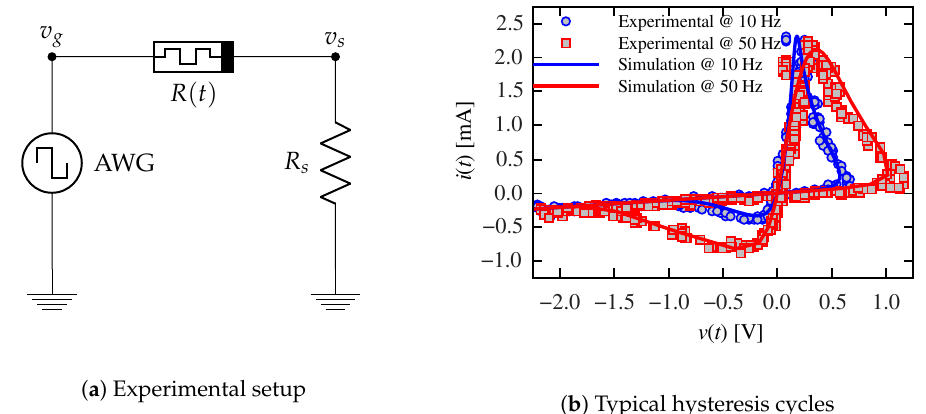
Figure 4. Emulator results: ( a ) experimental setup. The circuit under test is driven by an arbitrary waveform generator (AWG). Current through the memristor is measured as a voltage drop on an in-series resistor R s = 1 k Ω . ( b ) circuit current vs. memristor voltage: simulation (solid line) and measured emulator (points) results. The AWG provides a variable frequency sinusoidal signal with amplitude A = 2.5 V. The switching thresholds move towards higher voltage values when the input = 15 V − 1 , δ = 0.2 V, R on = 35 Ω , R = 9.5 k Ω , frequency increases. Parameters were set to α off ± ± v 0 = 0.3 V, and τ 0 = 0.01